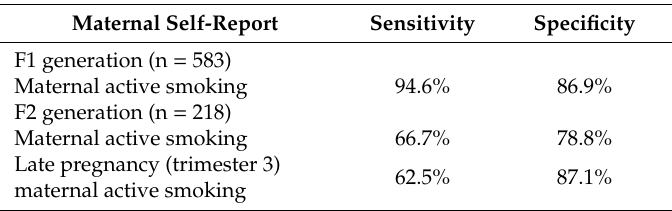
Table 4. Sensitivity and specificity of maternal self-report of active smoking in pregnancy compared to biochemical evidence of nicotine exposure in maternal (F0 mothers of F1 generation) and cord (F2 generation) sera, respectively.